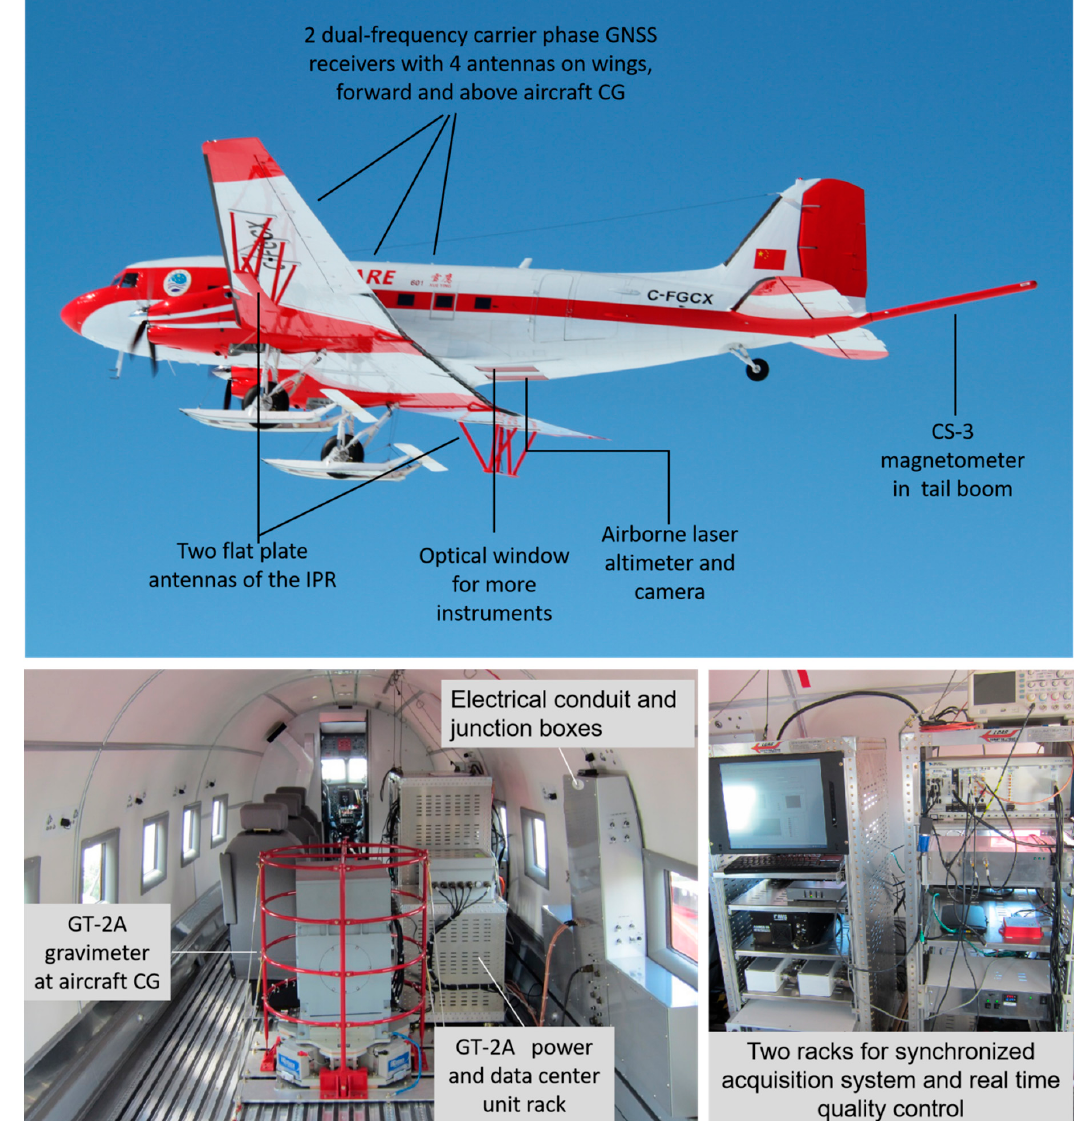
Figure 1. The Snow Eagle 601 platform and instruments.